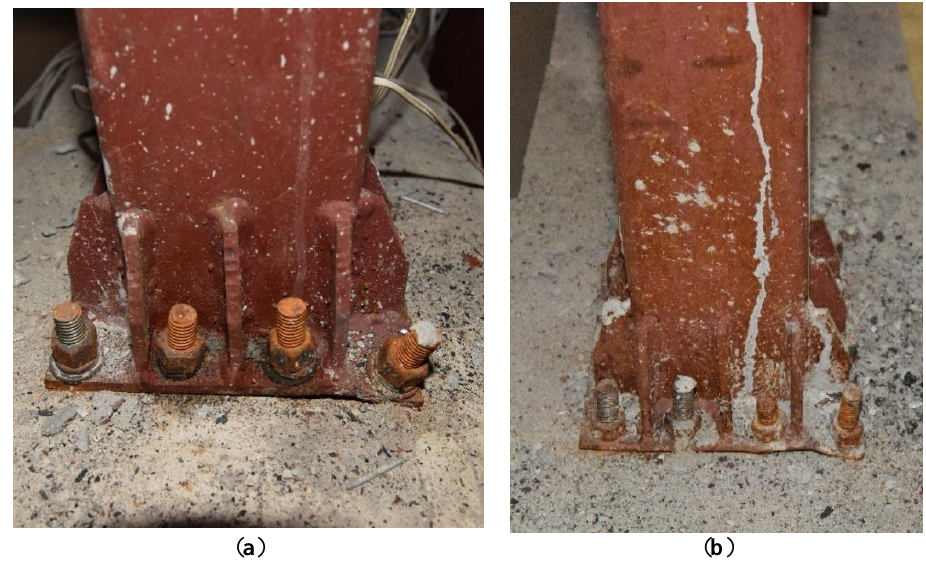
Figure 7. The deformation of the impacted column at column base. ( a ) Model A; and ( b ) Model B.